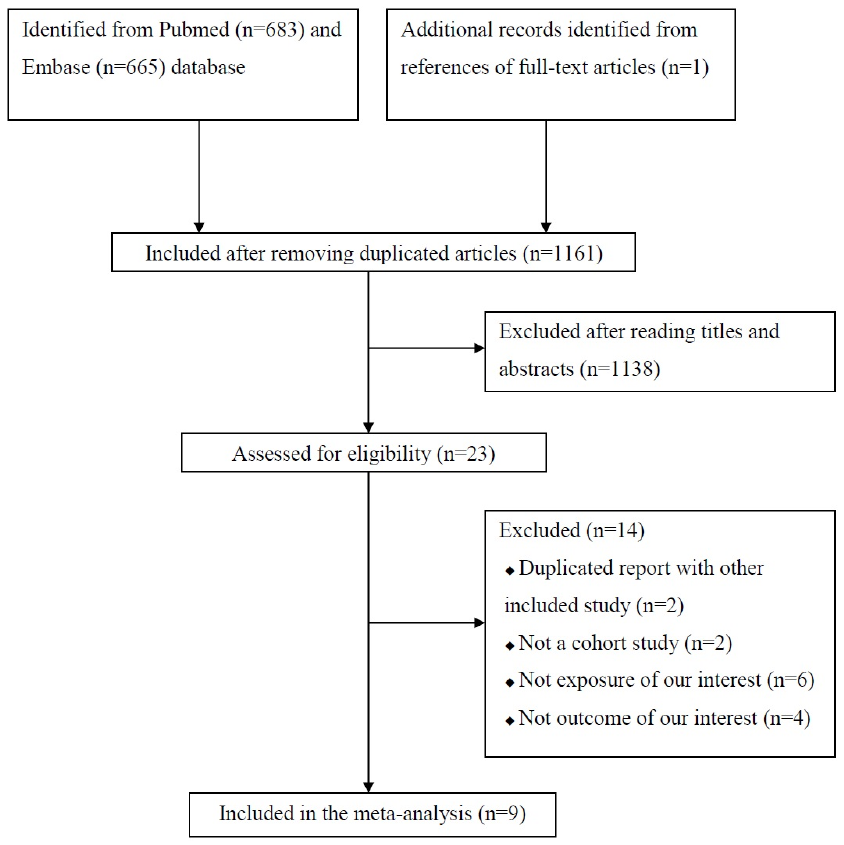
Figure 1. Flow diagram of articles included in the present study.